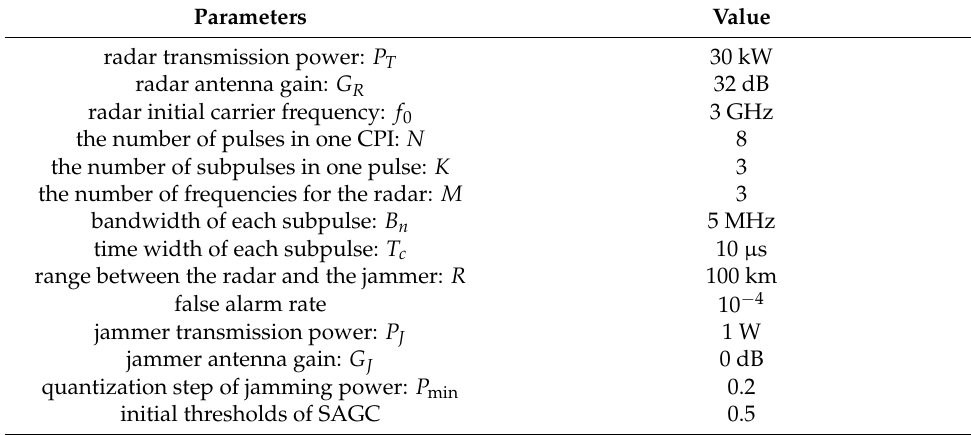
Table 3. Basic simulation